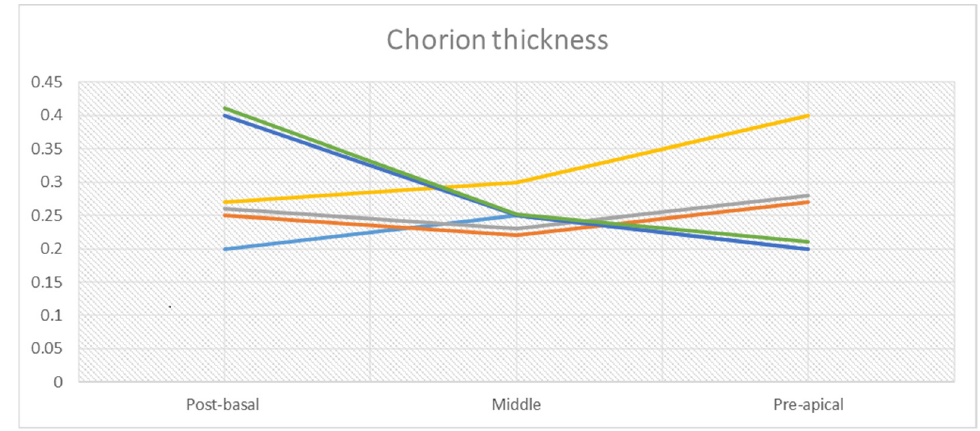
Figure 6. Mean chorion thickness of all six specimens, with progression from basal to apical portions.